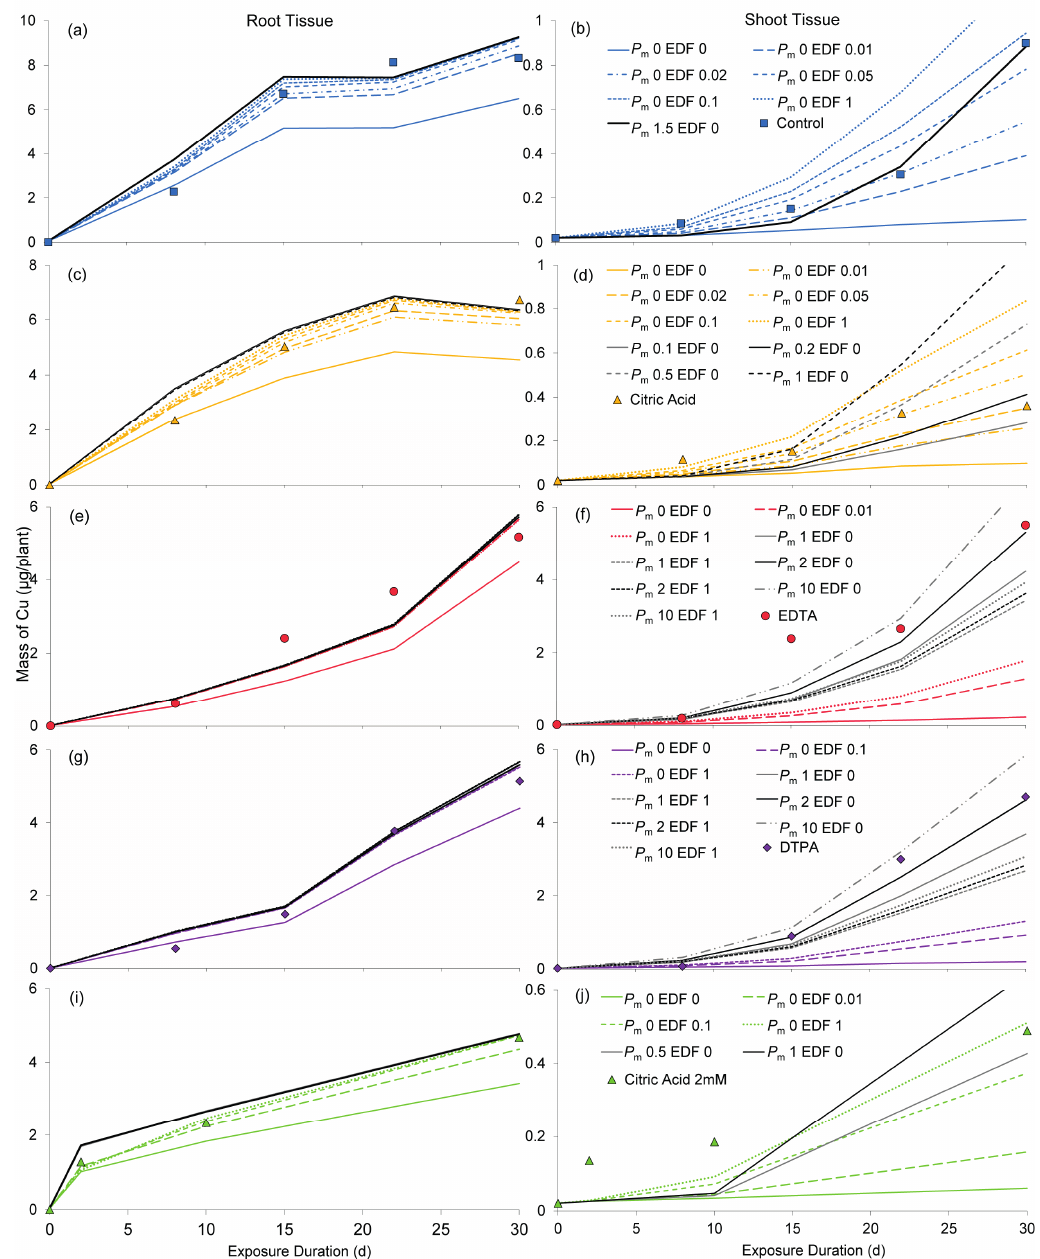
Figure 1. Simulations of total Cu mass (µg/plant) in plant tissues calibrated against experimental results for amendment treatments: ( a ) control roots; ( b ) control shoots; ( c ) 0.157 mM citric acid roots; ( d ) 0.157 mM citric acid shoots; ( e ) EDTA roots; ( f ) EDTA shoots; ( g ) DTPA roots; ( h ) DTPA shoots; ( i ) 2 mM citric acid roots; ( j ) 2 mM citric acid shoots Lines show simulations with varying membrane permeability ( P m ) and endodermal damage fraction ( EDF ) for simulated amendment treatments. Points without lines show experimental data presented previously